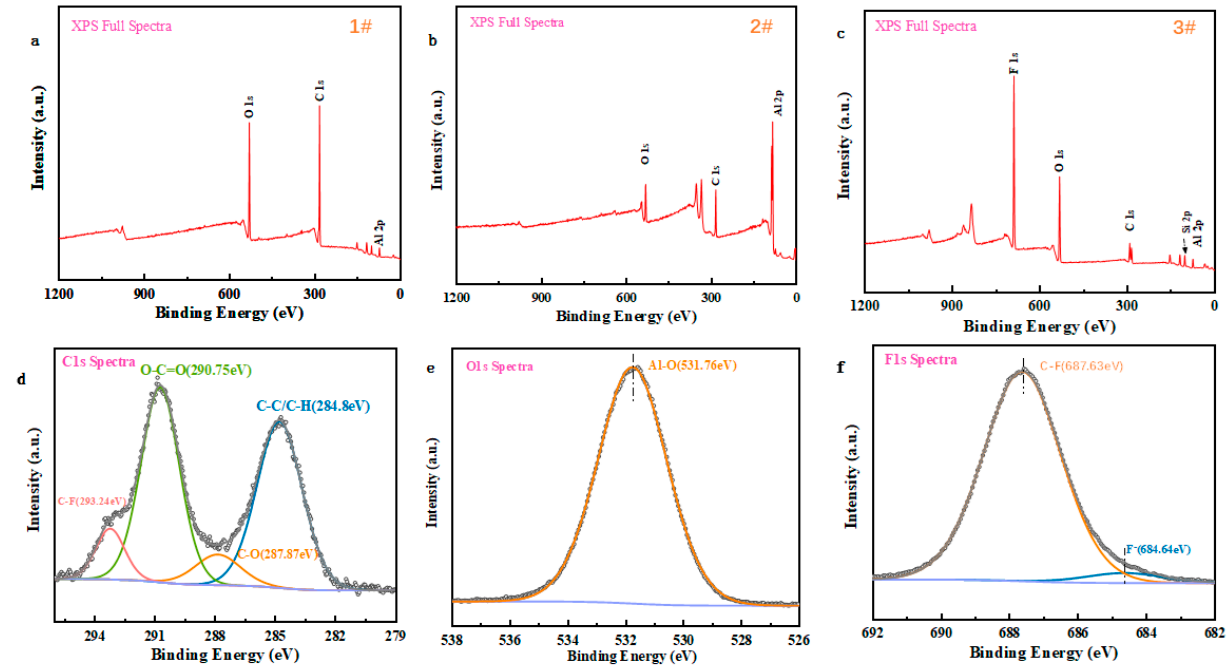
Figure 8. XPS spectra of each specimen. ( a ) Full spectrum of #1; ( b ) full spectrum of #2; ( c ) Full spectrum of #3; ( d ) XPS spectrum of C1s in #3; ( e ) XPS spectrum of O1s in #3; ( f ) XPS spectrum of F1s in #3.